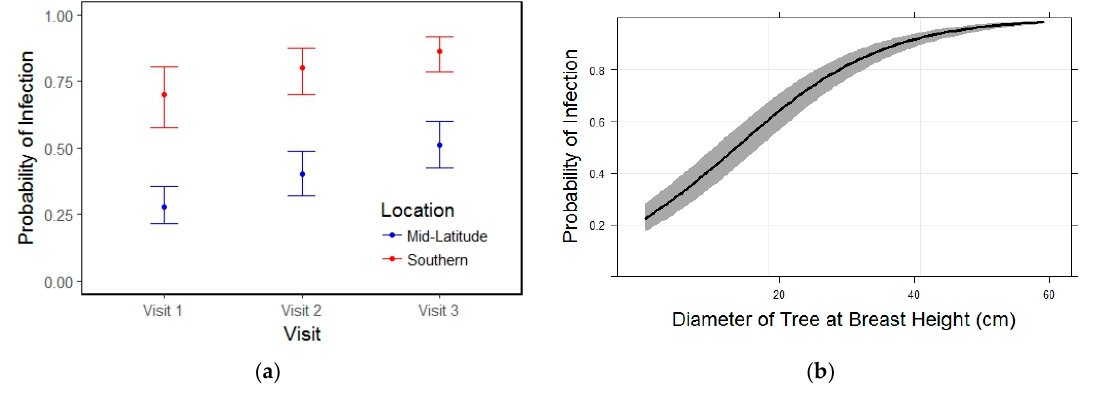
Figure 3. Fitted estimates of live tree infection by blister rust as a function of ( a ) visit for southern latitude (red) and mid-latitude (blue) locations in the study area and ( b ) tree diameter. Plots were constructed using the range of values for visit and latitude values for a southern and mid-latitude position for plot ( a ) and tree diameter for ( b ) while holding remaining predictor variables at their mean values for the study area. Confidence intervals (alpha = 0.05) are shown.